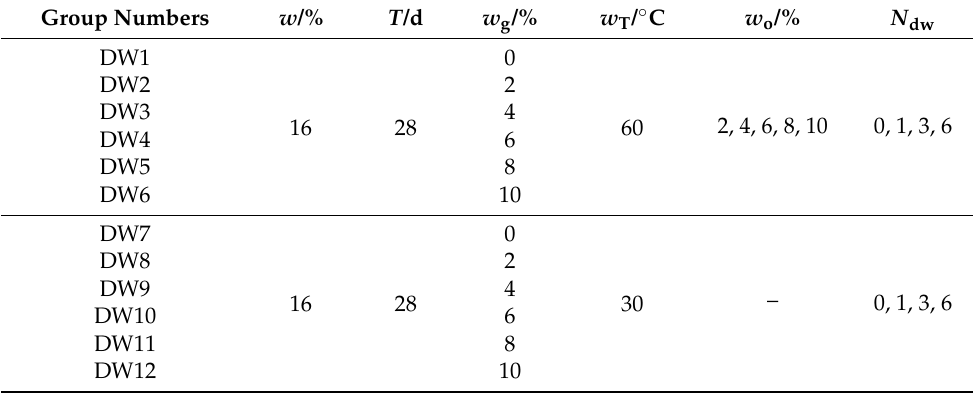
Table 5. Experimental design of dry-wet